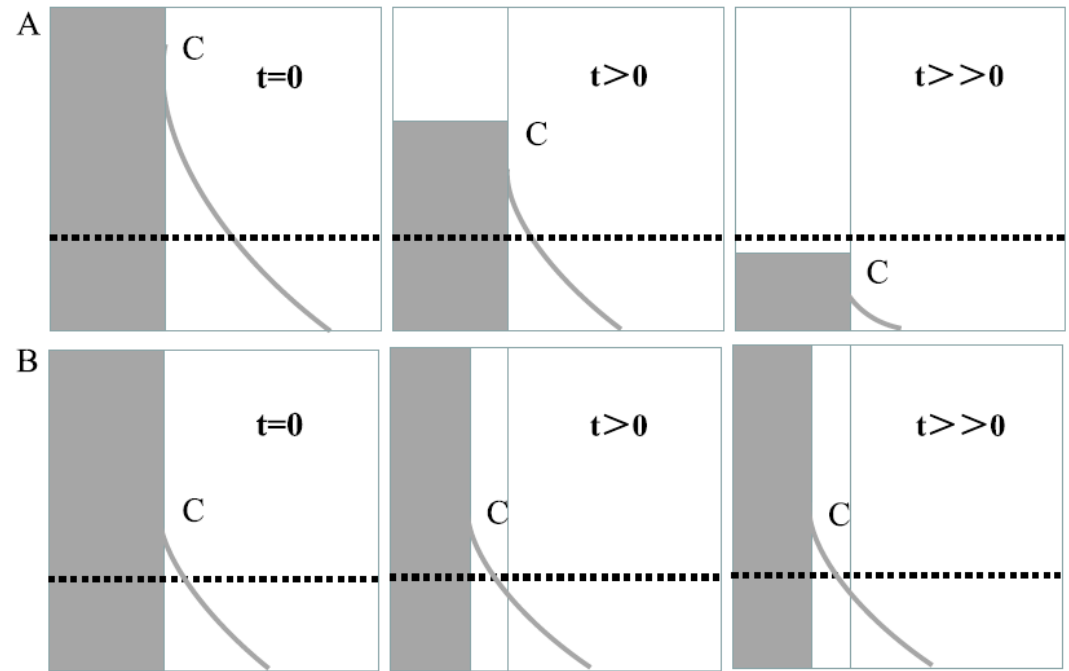
Figure 12. Possible methods for the release of antimicrobial agents in active packaging. Reproduced with permission from [1]. (Copyright 2020 Elsevier).